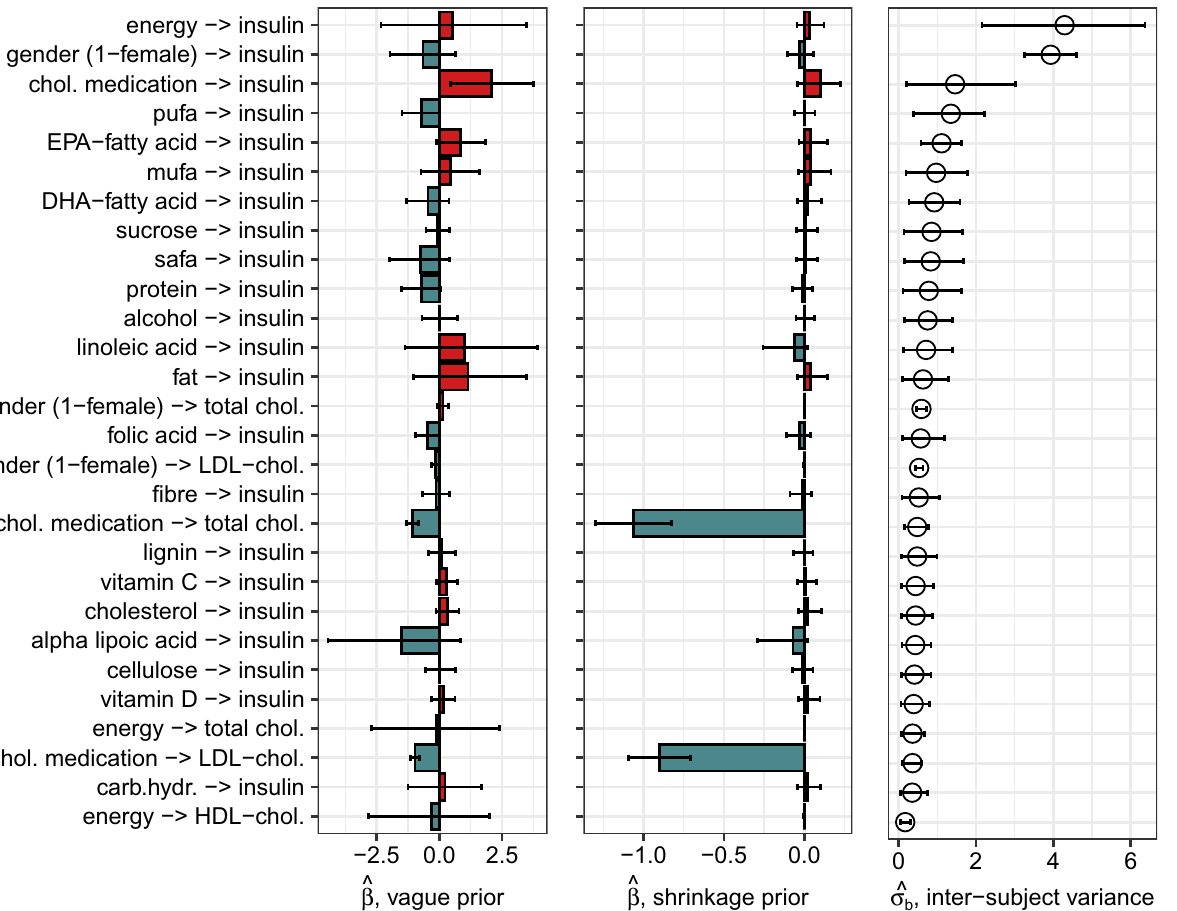
Figure 4. List of nutritional effects where the effect is either generally strong or it has high variation between subjects. If a generally insignificant effect, with low significant for someone. The figure shows posterior means with 90%-credible intervals and compares the effect of shrinkage prior (7) to vague prior (6) in language (v 3.3.2, https:// ggplo t2. tidyv erse.